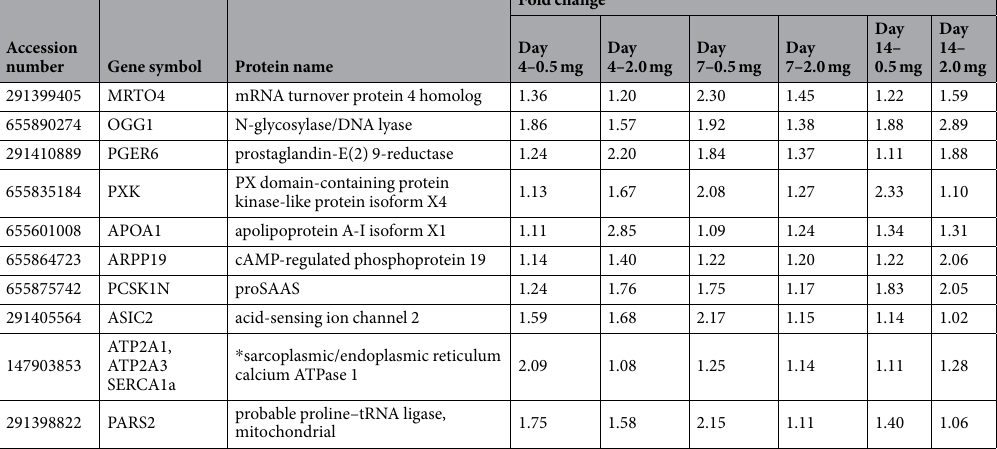
We used 10-plex TMT-labeled proteomic quantification to analysis the variation of proteins in the retina of conbercept injected eyes. This technique has been demonstrated to be a powerful method to reach very large coverage of the proteome and to discover differentially expressed proteins (DEPs). Although the proteomic was based on a database of rabbit protein, it could help us to understand the protein alternation after intraocular administration of conbercept. To the best of our knowledge, this is the first study to explore DEPs in the retina after intraocular administration of an anti-VEGF drug. Among 6042 proteins quantified, we identified 250 proteins (~4%) altered by more than 2.0-fold or less than 0.5-fold with greater than 95.0% probability at least at one time point or dosage in the eyes applied with 0.5 or 2.0 mg conbercept at day 4, 7 or 14. The only protein that reached more than 10-fold increases was VEGFR1. It was not surprise since conbercept is a recombinant fusion protein contains several ligand binding domains including VEGFR 1. Increase of VEGFR1 should be a consequence of increase of exogenous conbercept. On the other hand, the data proved the efficacy of the assay. Proteomic analysis did not show significant changes of cell death or inflammation associated proteins in the conbercept-injected eyes. No increase of cytokine, chemokine or neuroinflammation related proteins was observed. Compared with the untreated group, conbercept did not cause substantial changes of the expressions of growth factors. Although the complement C3 alpha chain isoform X1 partial 1 was detected, no any other related proteins were found. In the complement and coagulation cascades pathway, the levels of three fibrinogens were higher than the control but these proteins are also related with platelet activation. Thus, alternation of the com- plement C3 alpha chain isoform X1 partial 1 maybe associated with platelet activation, rather than inflammation. Platelet activation was detected as the most enriched pathway after conbercept injection. Fibrinogen alpha chain, fibrinogen beta chain and fibrinogen gamma chain isoform X2 increased at day 7 after injection. It has been shown that application of ranibizumab and bevacizumab may contribute to a risk of systemic thromboembolic events in elderly patients 28 . Up-regulation of three fibrinogens after conbercept injection might raise a concern whether the proteins could be a potential risk factor. Research revealing the fibrinogen concentration in circula- tion would be helpful. Mitochondrial adenosine triphosphate synthase (ATPase inhibitor) was up-regulated at all three time points. Bevacizumab was reported to show mild mitochondrial toxicity at clinically doses 29 . Five mitochondrial proteins were altered significantly with four up-regulated involved in steroid biosynthesis, lipoic acid metabolism, pyrimi- dine metabolism, glycerophospholipid metabolism and one down-regulated in amino acid metabolism. In the protein processing in endoplasmic reticulum, alpha-crystallin A chain was approximately 2-fold at day 4 and 1.5-fold increased at day 7 and 14 after injected with both dosages of conbercept. Alpha-crystalline is a member of heat shock protein family and acts as chaperones which is acknowledged to be a neuroprotective substance 30 . The Graves disease carrier protein (GDC) was down-regulated after conbercept injection at all three time points and decreased more than 5 folds in the 2.0 mg group at day 7. GDC is recognized in patients with active Graves disease (GD). In the riboflavin (Vitamin B 2 ) pathway, the expression of riboflavin (RF) kinase in the conbercept-injected groups decreased at all three time points. ATP:riboflavin kinase catalyzes the synthesis of cofactor flavinmono- nucleotide (FMN) by transforming riboflavin and ATP into FMN and ADP. RF is of physiological and nutritional importance in the maintenance of health of the retina 31 . There are inevitable limitations for this study. First, we injected recombinant human fusion protein into the rabbit eyes. The data was obtained form a rabbit database and the protein information could not be completely used to predict the outcome in human. Second, the cutoff we set for protein changes is 2 folds. Thus we can’t exclude the possibility that a protein presents a fold change less than the threshold will not exert functional changes. However, since such investigation can’t be duplicated in human subjects, the first retinal proteomic study